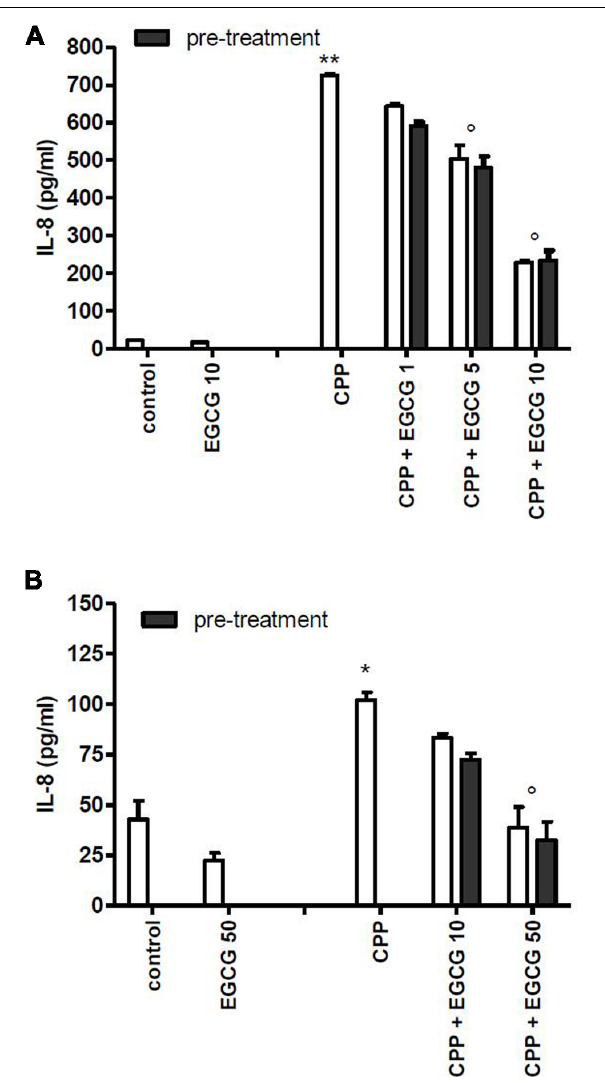
FIGURE 2 | Effect of 1 h pretreatment of cells with EGCG before CPP crystal stimulation on IL-8 production. Results from FLS (A) andTHP-1 (B) cells.The values are expressed as the mean ± SD; CPP 0.025 mg/ml; EGCG expressed as micromolar. Data are representative of one of three independent experiments ± SD of three replicates. * p < 0.05, ** p < 0.01 vs control; ◦ p < 0.05 vs CPP.